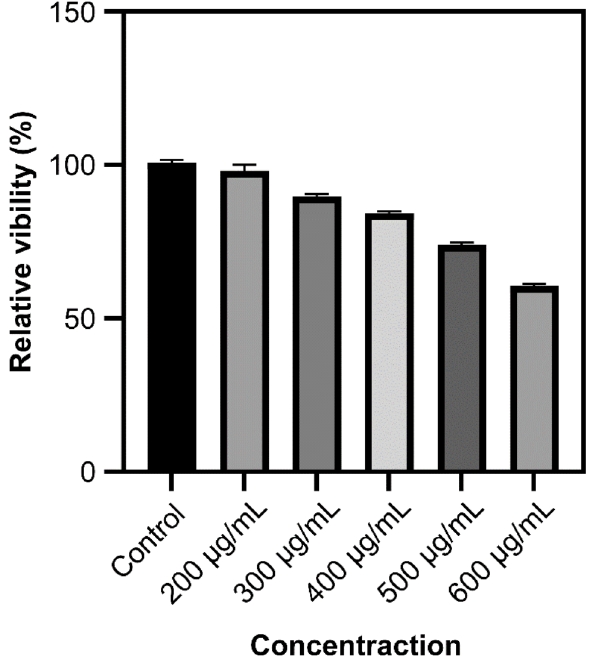
Figure 8. Cytotoxicity of different concentrations of Ag-UCNPs. A reverse microemulsion method was used to fabricate a SiO 2 shell structure coated with Ag-UCNPs. Moreover, TEM was used to confirm that SiO 2 successfully coated Ag-UCNPs (Figure 9).